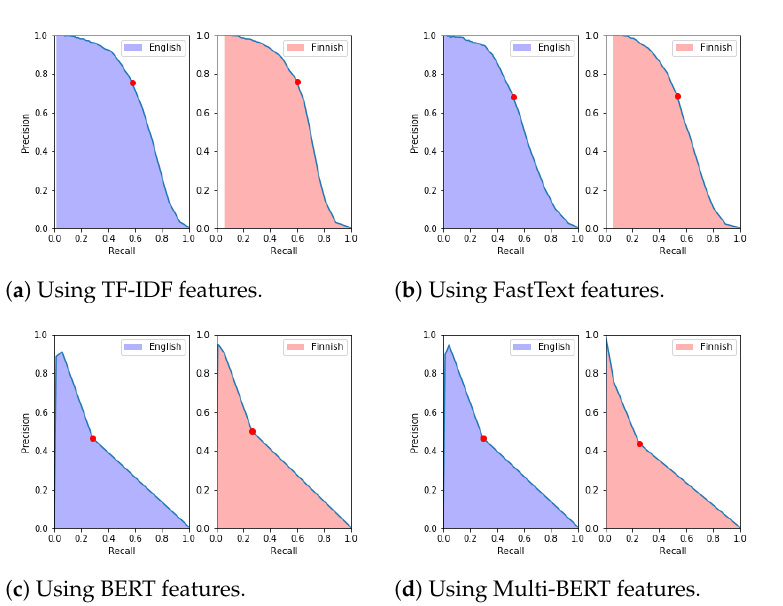
Figure 6. Precision-Recall curves obtained from evaluating the combination of the ML-kNN model with the feature extraction methods. The red dots represent the point where the corresponding maximum F1 score was measured for every plot.